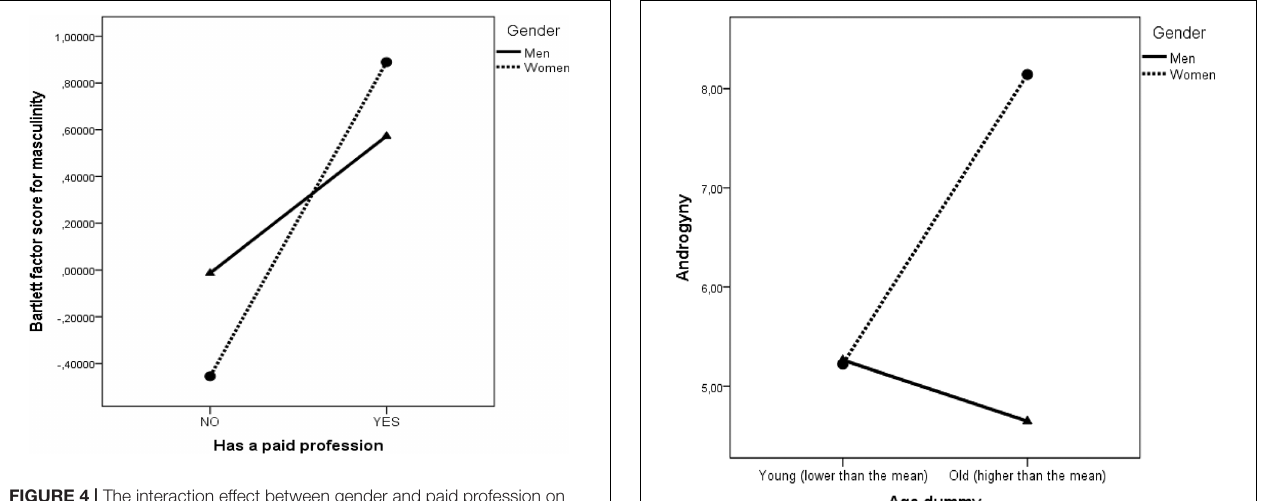
FIGURE 4 | The interaction effect between gender and paid profession on masculinity.